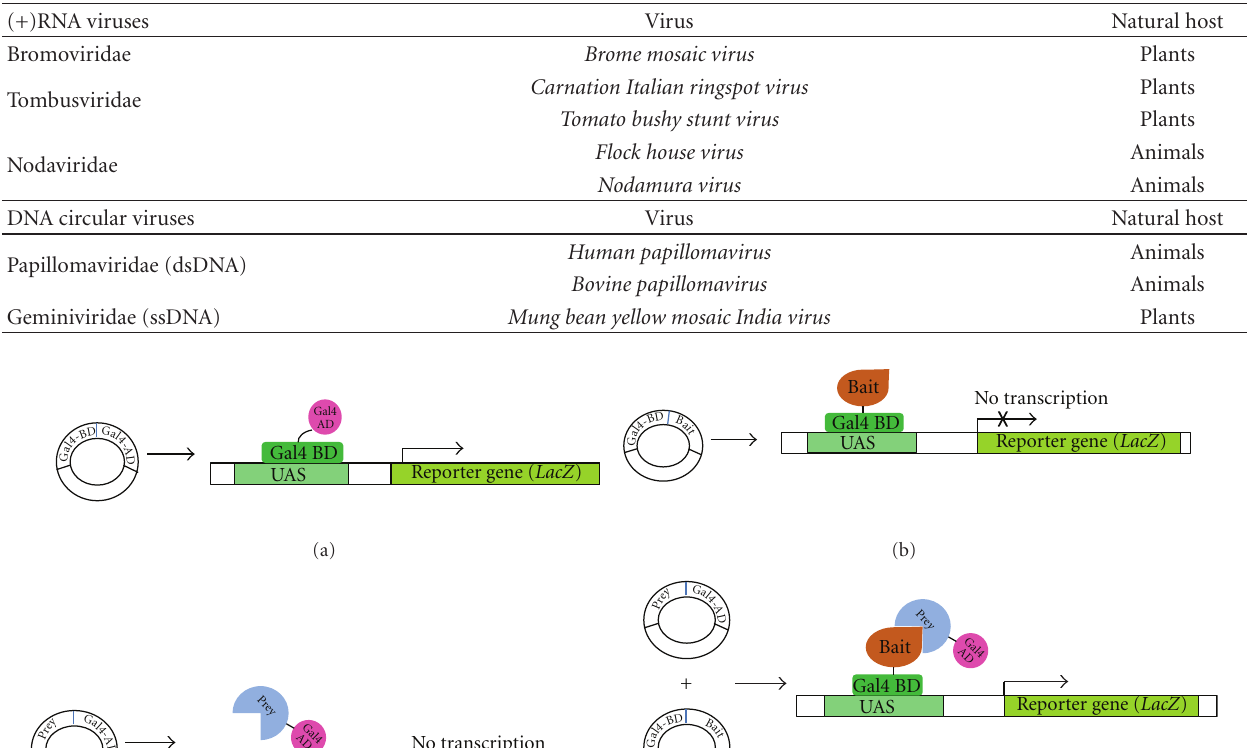
Table 1: Viruses that replicate in yeast.